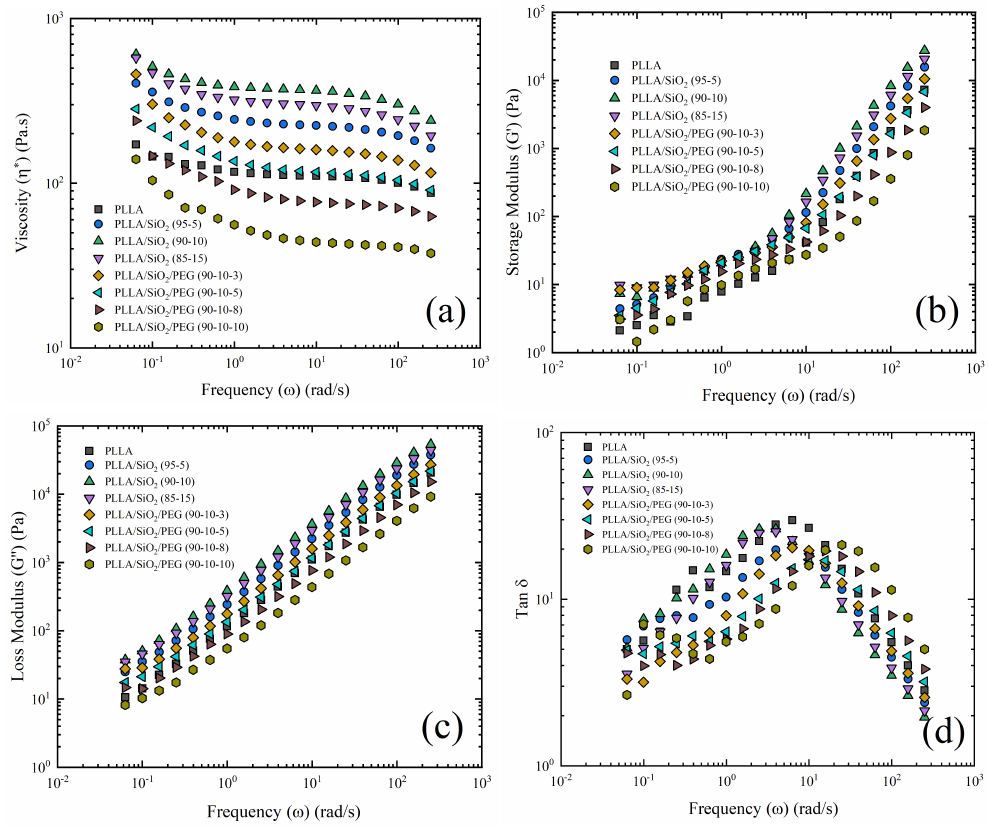
Figure 9. Rheological properties as a function of frequency: ( a ) complex viscosity, ( b ) storage modulus, ( c ) loss modulus, and ( d ) damping factor (tan δ ) for PLLA, PLLA/SiO 2 , and PLLA/SiO 2 /PEG (190